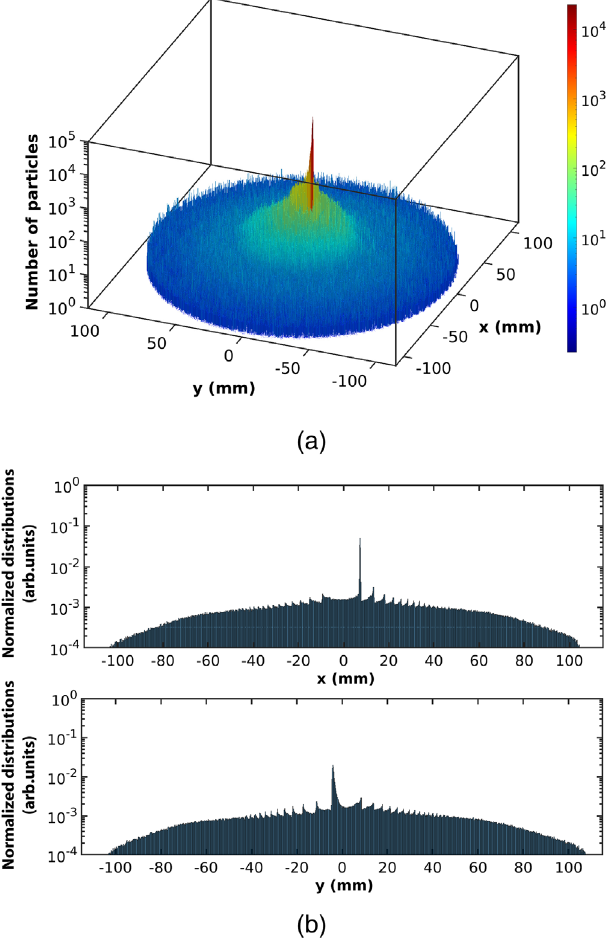
FIG. 4. (a) Spatial distributions in the cyclotron plane of the beam losses produced by gas stripping. (b) Normalized distri- bution over the total amount of stripping losses along different directions.